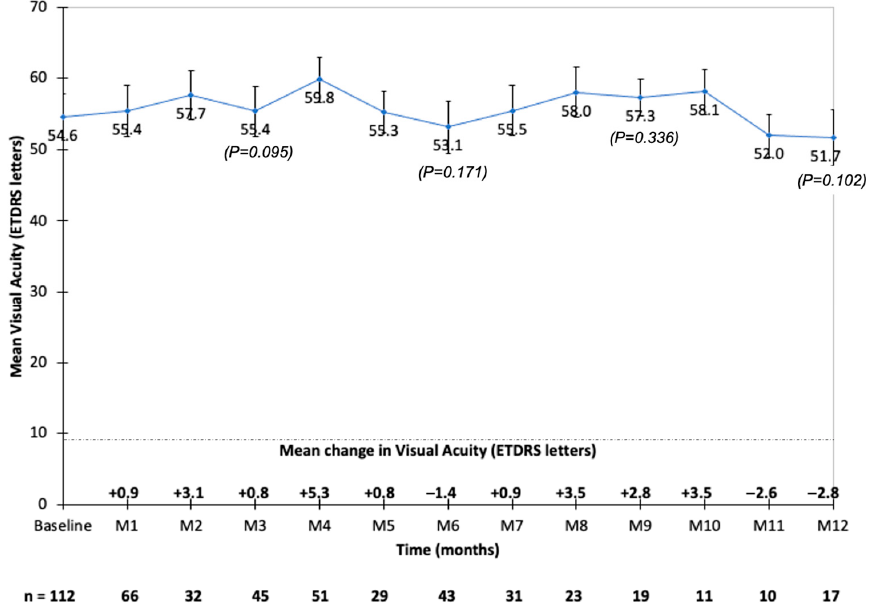
Figure 1. Mean best-corrected visual acuity (BCVA) and mean change in BCVA during the follow-up